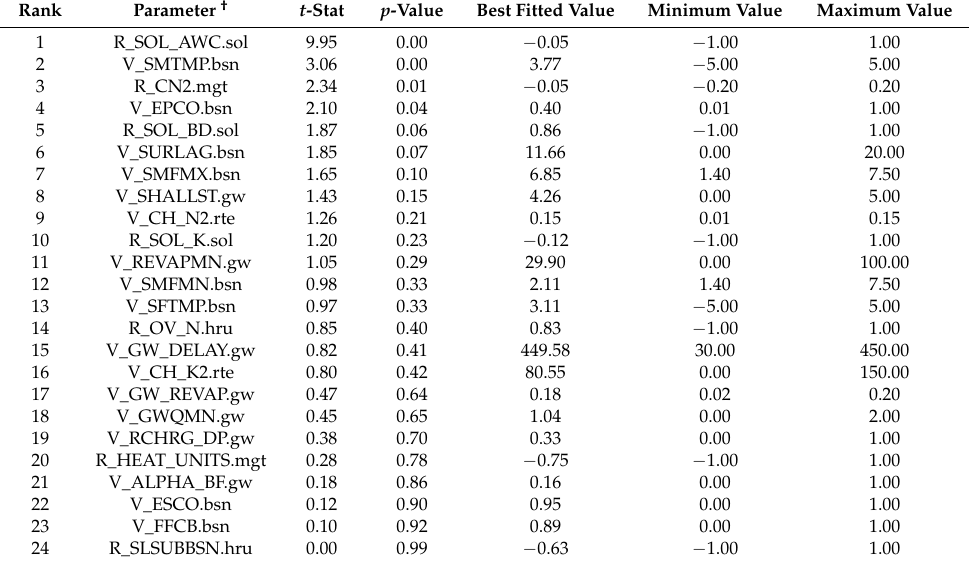
Table 1. Parameters and their range selected to calibrate the model using Sequential Uncertainty Fitting 2 (SUFI 2) within Soil and Water Assessment Tool Calibration Uncertainty Program (SWAT CUP), their sensitivity ( t -stat and p -value determine the rank for each parameter) and best fitted value used to calibrate and validate the SWAT